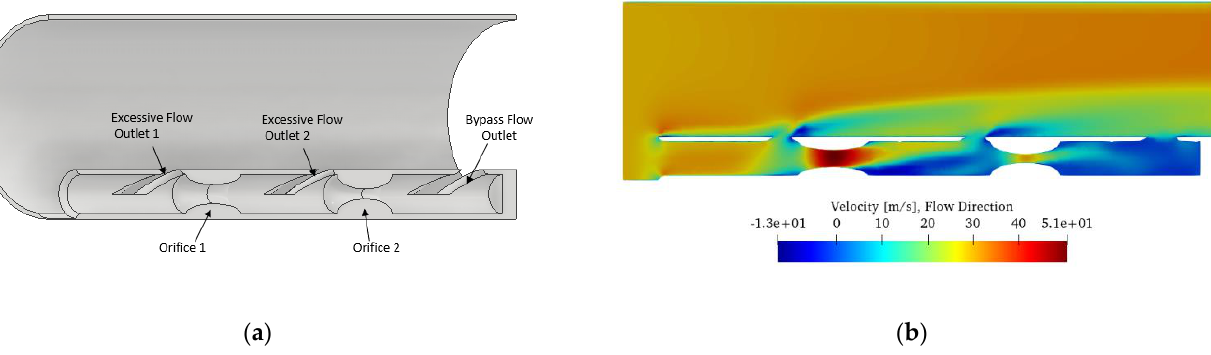
Figure 4. ( a ) test design concept (2) 3D, mid-section; ( b ) test design concept (2) simulation result.